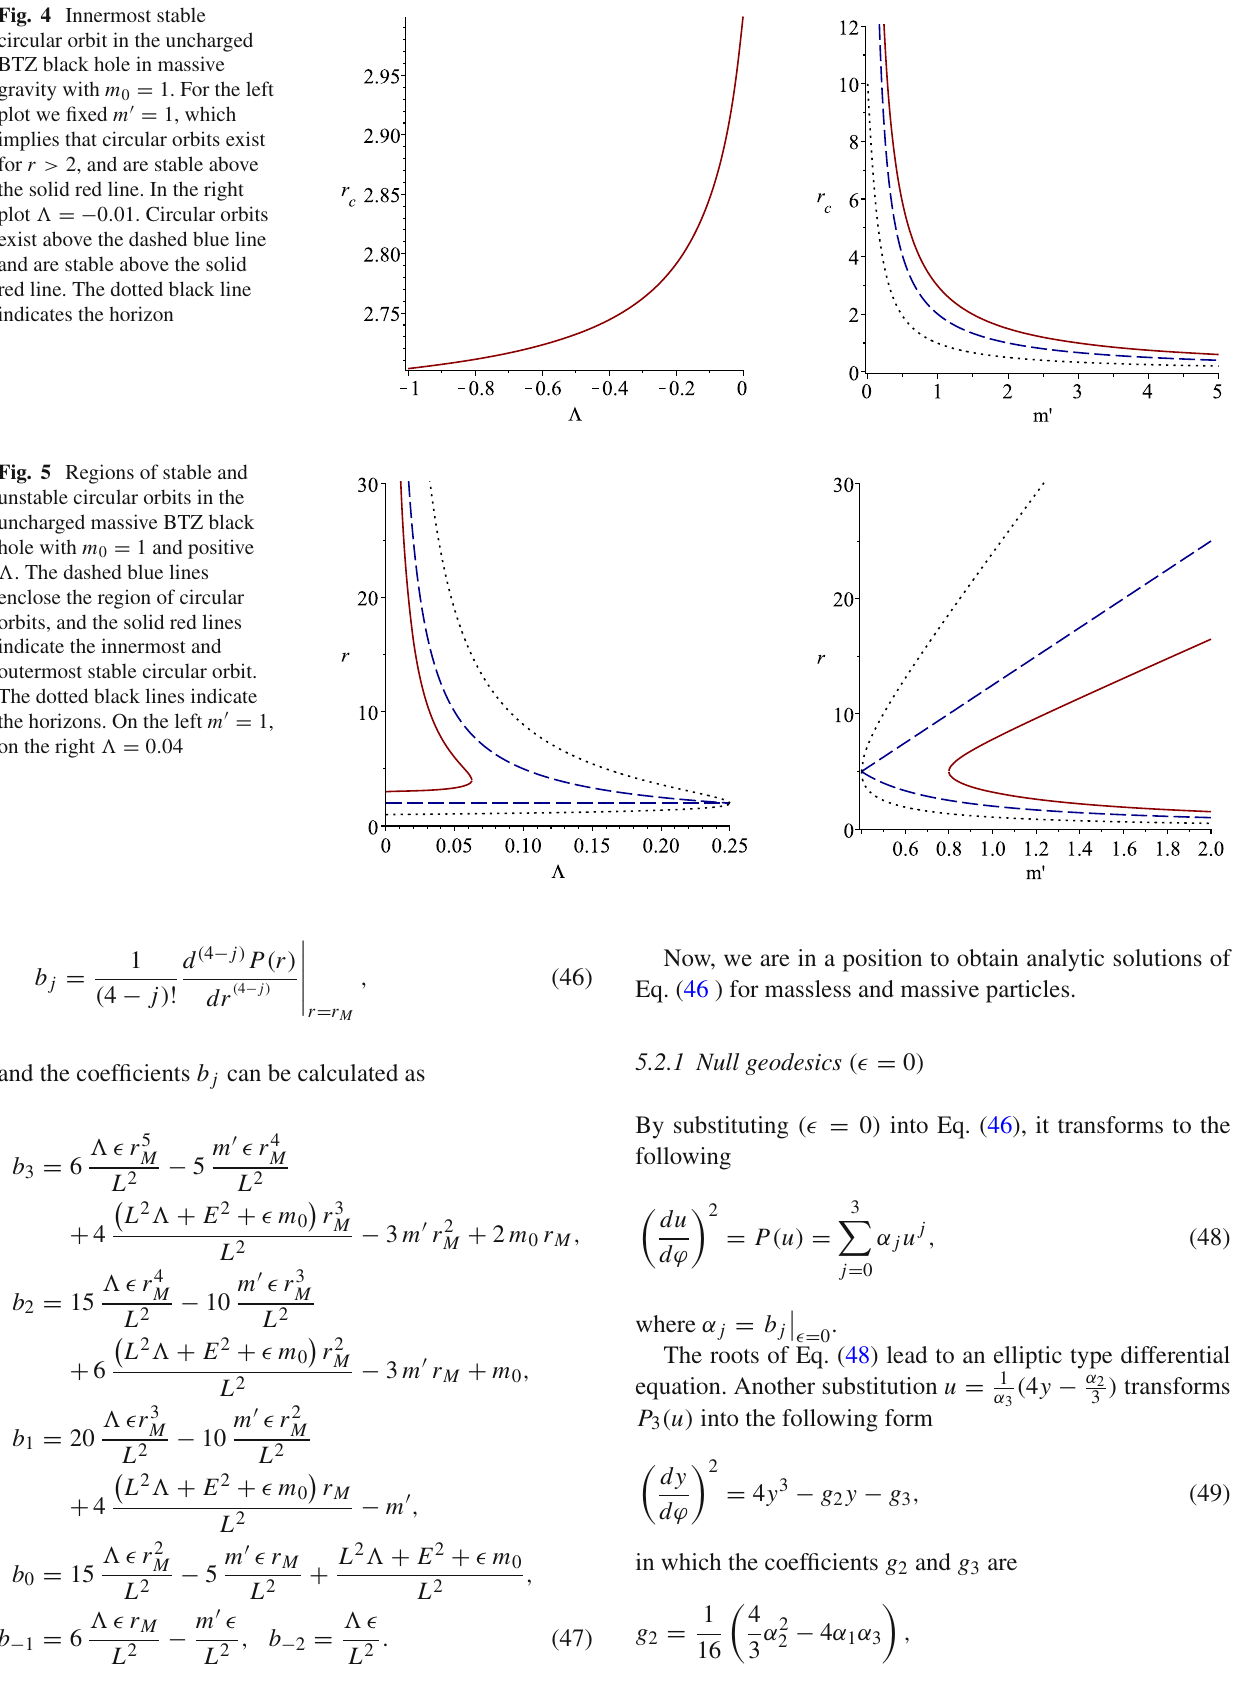
Fig. 4 Innermost stable circular orbit in the uncharged BTZ black hole in massive gravity with m 0 = 1. For the left plot we fixed m (cid:5) = 1, which implies that circular orbits exist for r > 2, and are stable above the solid red line. In the right plot (cid:4) = − 0 . 01. Circular orbits exist above the dashed blue line and are stable above the solid red line. The dotted black line indicates the horizon